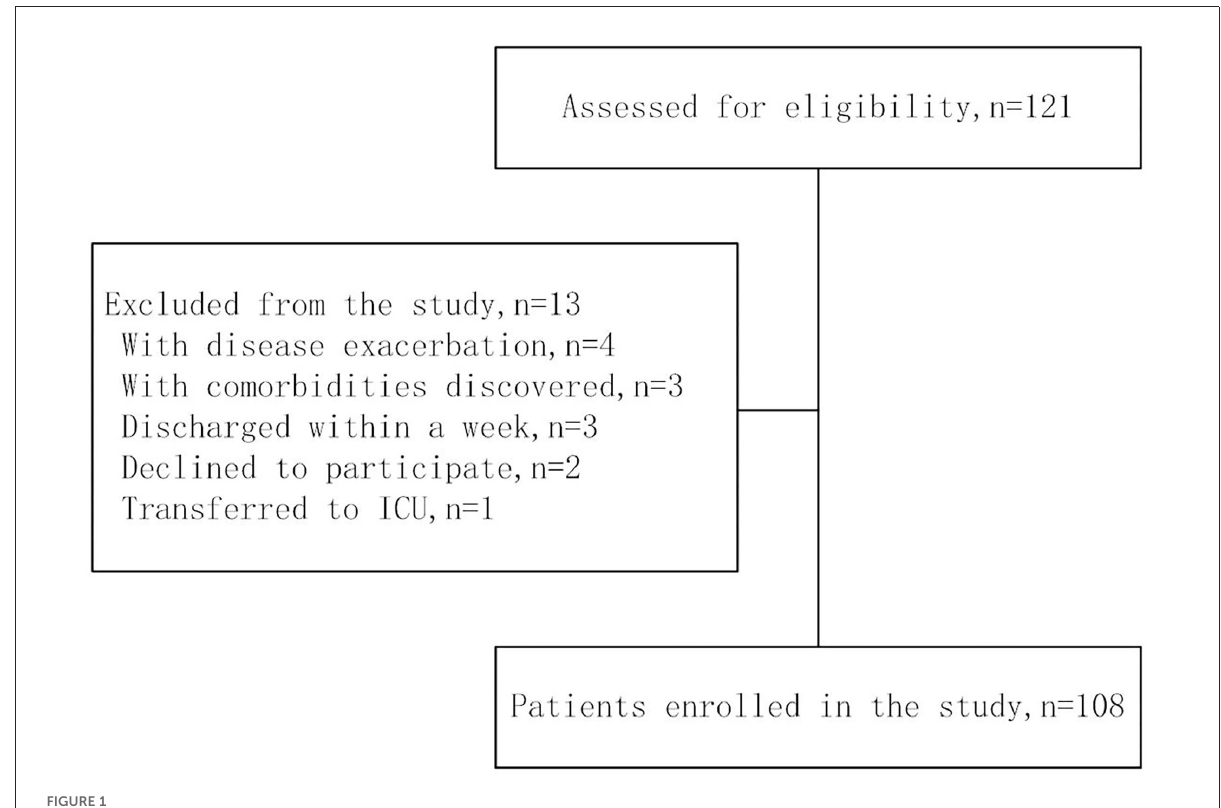
FIGURE1 Flow chart of